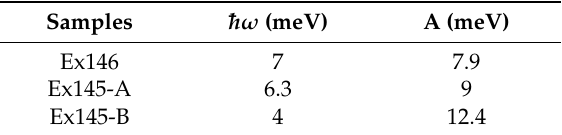
Figure 3. Temperature dependence of full width at half maximum (FWHM) of PL spectrum for: ① Ex145-B; ② Ex145-A; and ③ Ex146. Solid line is a fit to Equation (5) for each data. Table 3. Energy of variation mode of excited state ( ℏ ω ) and FWHM ( A ) of PL exported to 0 K for GaInP epitaxial layers.